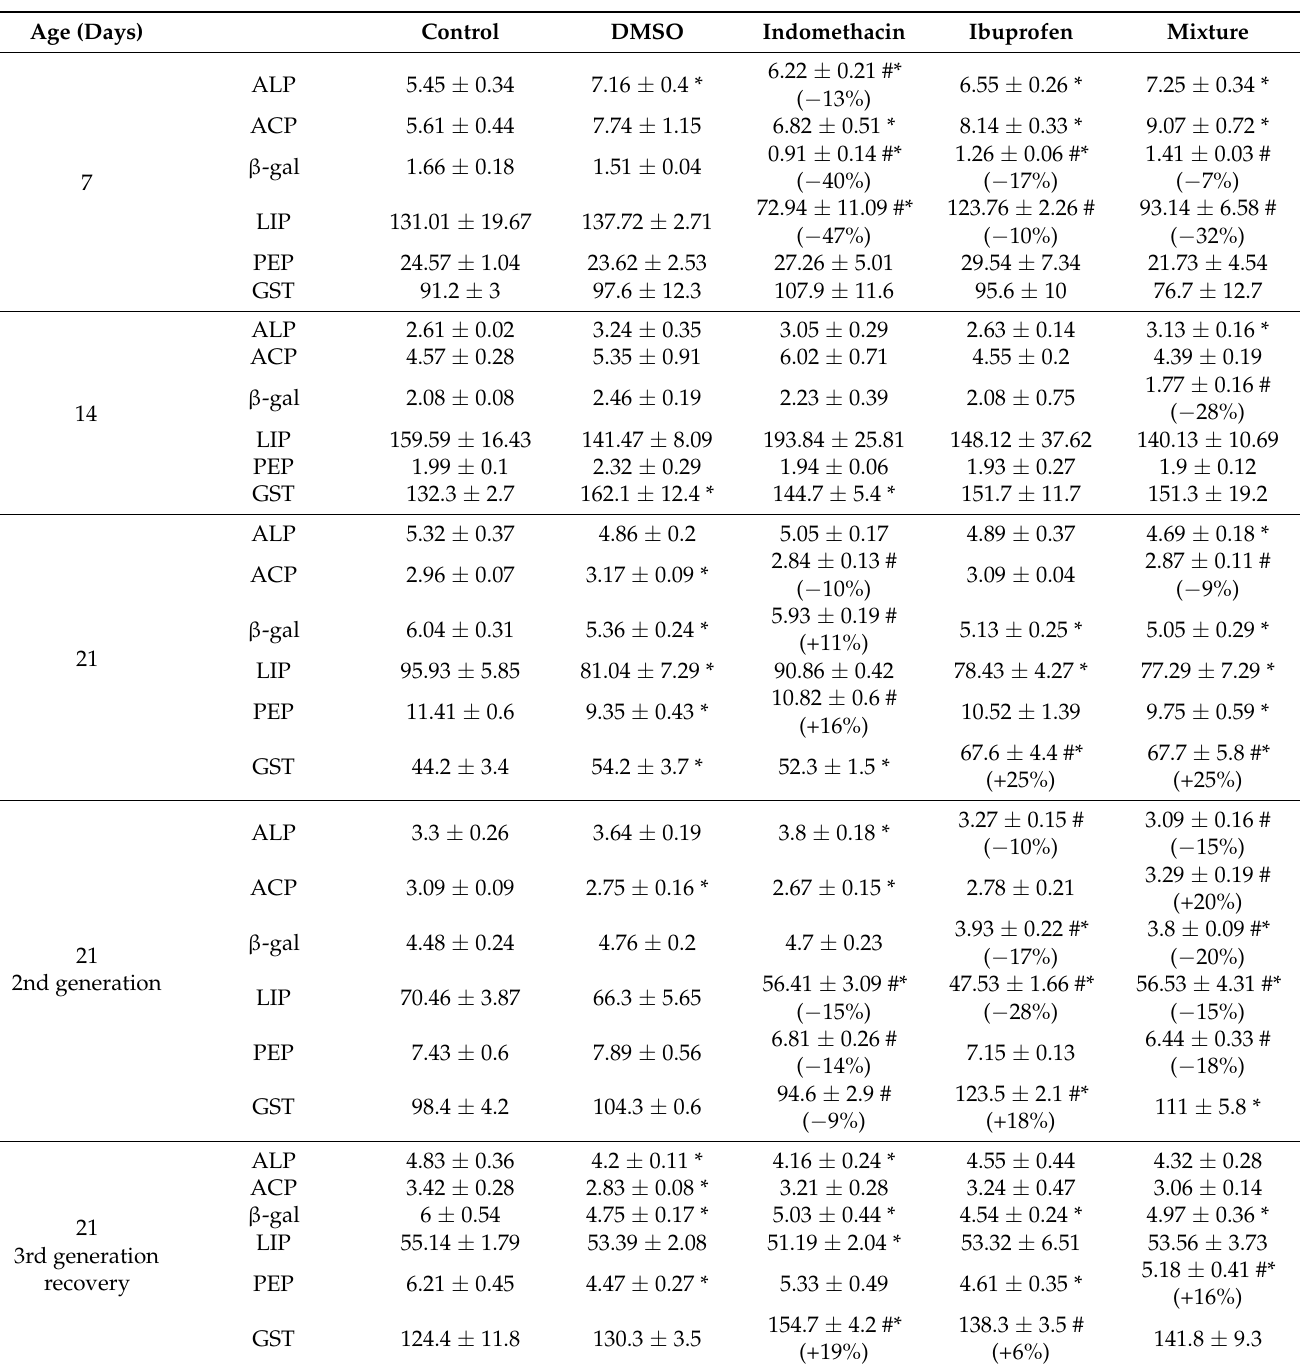
Table 2. Biochemical markers of daphnid physiology following chronic and transgenerational exposure to NSAIDs. Data represent mean ± standard deviation (N = 4 replicates) of enzyme activity. Enzyme activity was expressed as units/mg protein for phosphatases, β -gal, LIP, and PEP, and as munits/mg protein for GST. Symbols (#) and (*) indicate statistically significant differences by Student’s t -test compared with DMSO and control,